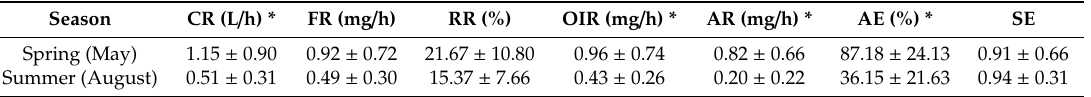
Table 7. Mean values ( ± s.d.) of physiological responses mussels standardized by 1 g weight. (*) Significant ( p < 0.05) di ff erences between